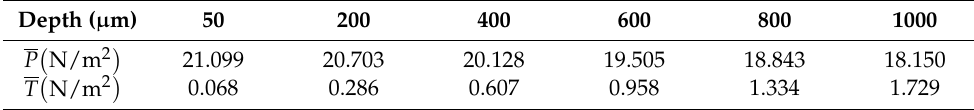
Table 1. Magnitudes of normal and shear tractions on crack surface.